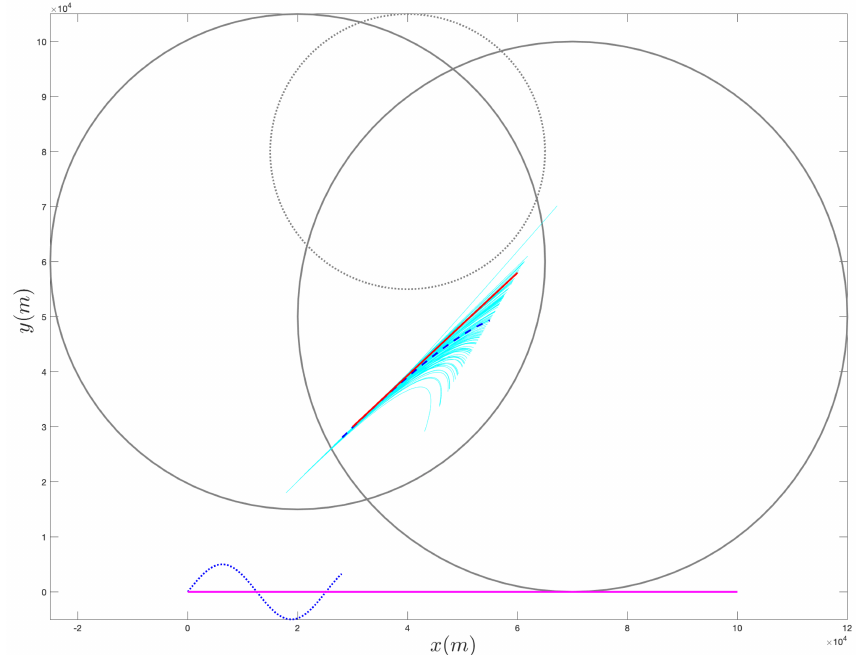
Figure 8. Sampling of 100 trajectories (cyan) based on the best solution found via for the constrained case, but without relying on the APF, and on the experimental covariance